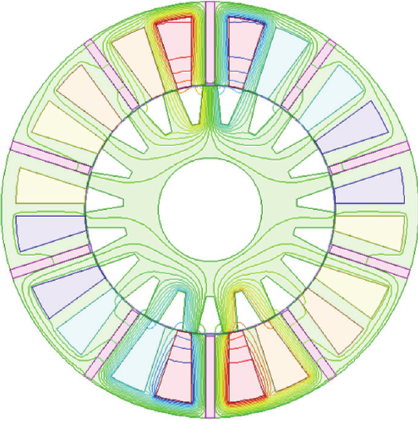
Figure 2: Magnetic field distributions of FT-FSPM motor by armature current